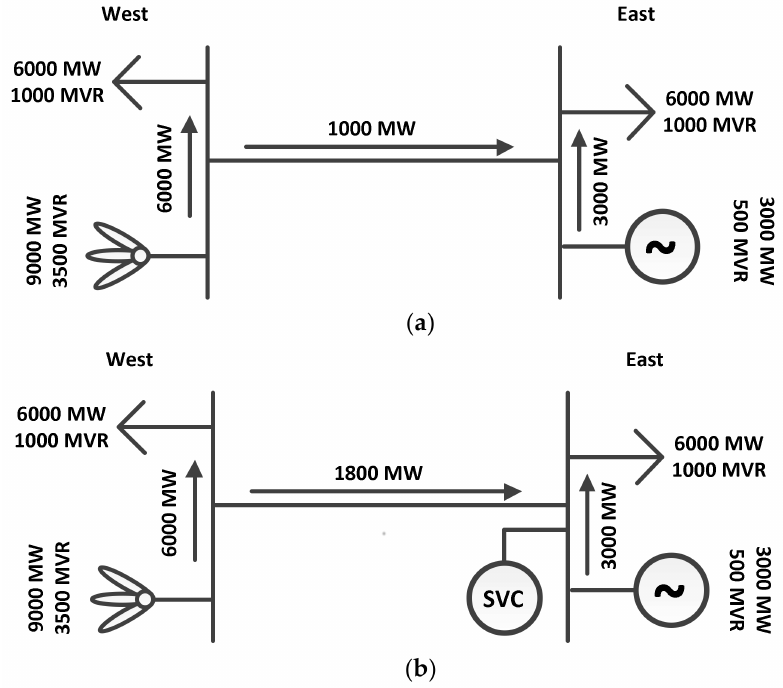
Figure 1. Power system: ( a ) without static VAR compensator (SVC) and ( b ) with